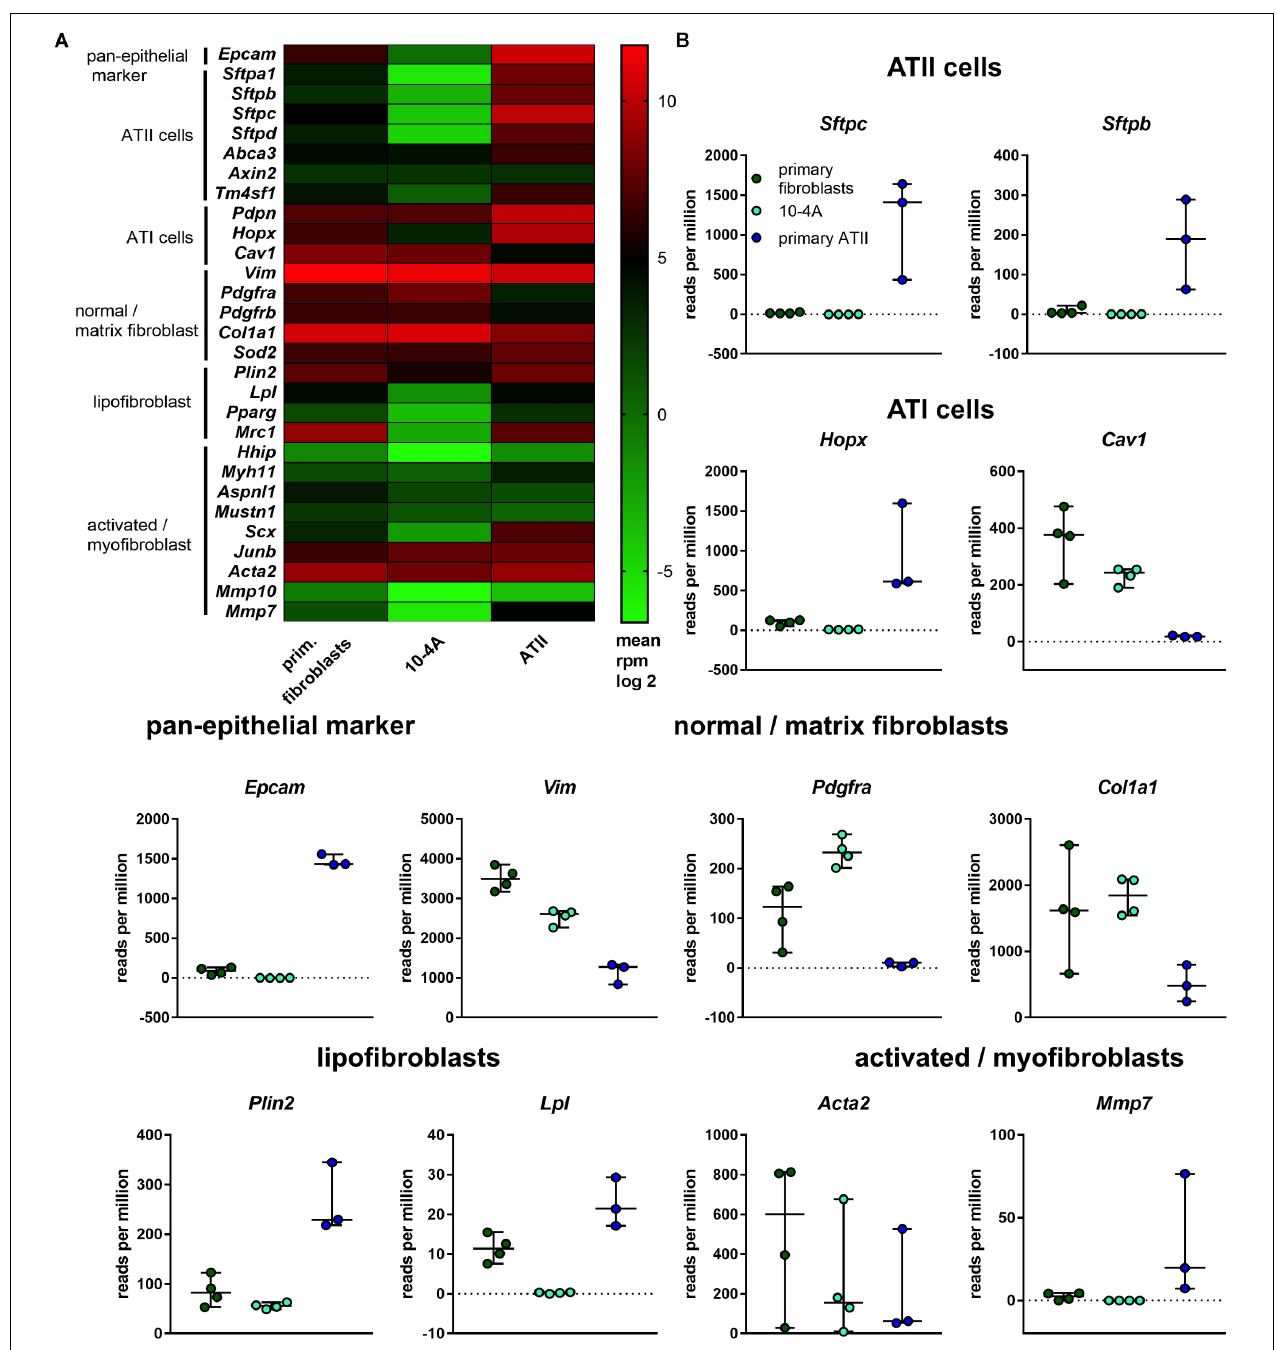
FIGURE 2 | Transcriptomic profile of 10-4A compared to freshly isolated rat fibroblasts and ATII cells. (A) Heat map of selected pan-epithelial, ATII, ATI and different fibroblast subtype marker genes. Values are given as log2-fold change of the mean reads per million base pairs. 10-4A and primary fibroblasts, N = 4, primary ATII cells, N = 3. (B) Detailed presentation of rpm values obtained for selected marker